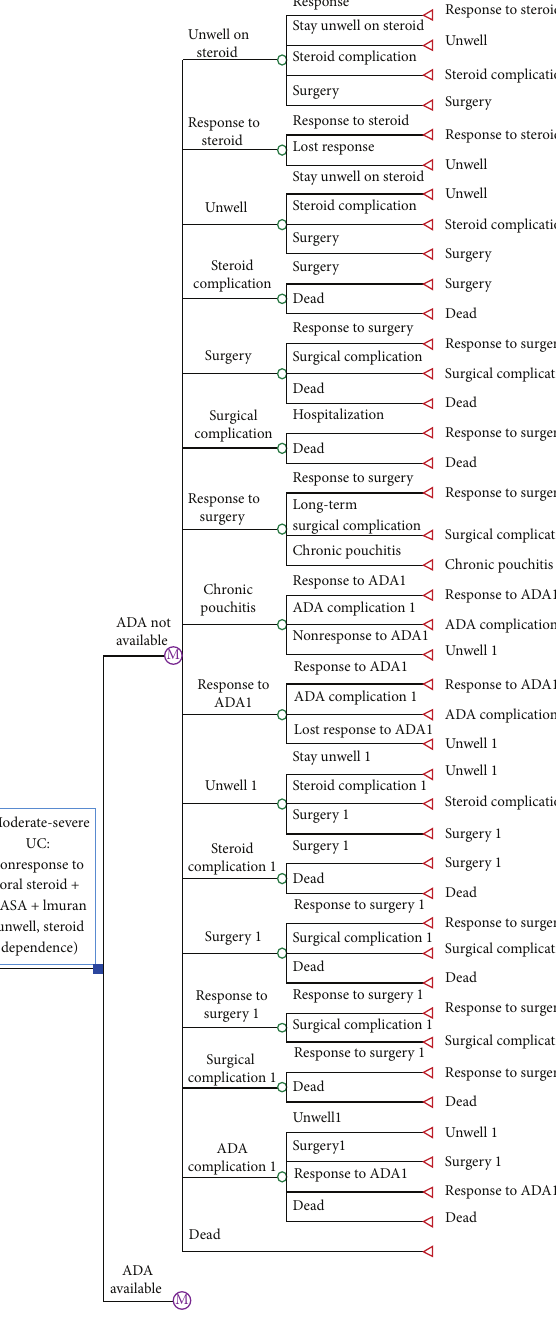
Tables 3 and 4 outline the costs of each health state per